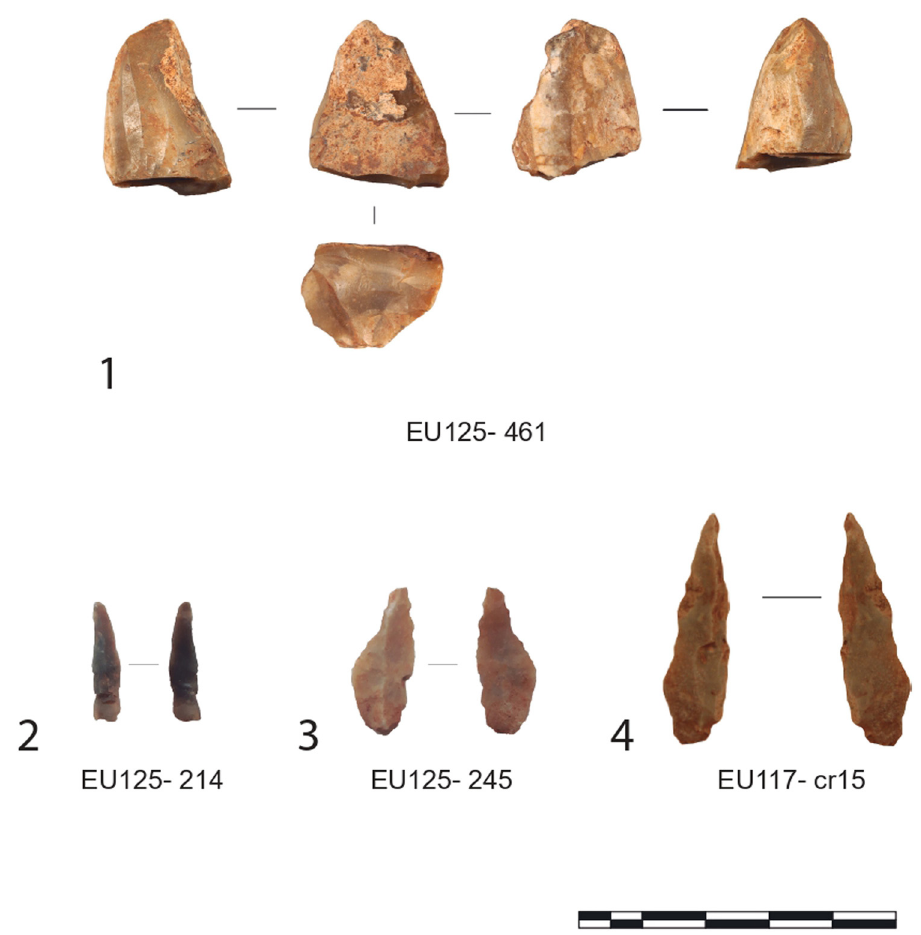
Figure 5: Selection of lithic pieces from the study. ( 1 ) Pyramidal core and ( 2 – 4 ) blade - like support